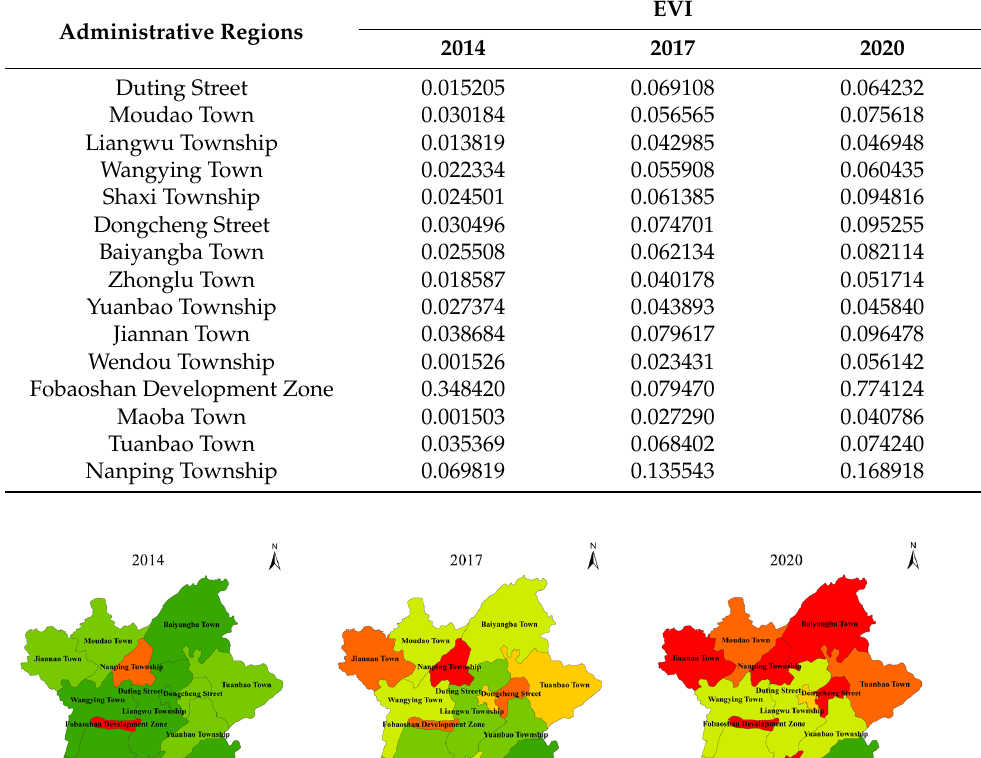
Table 7. The EVI of forest landscape in each administrative region.